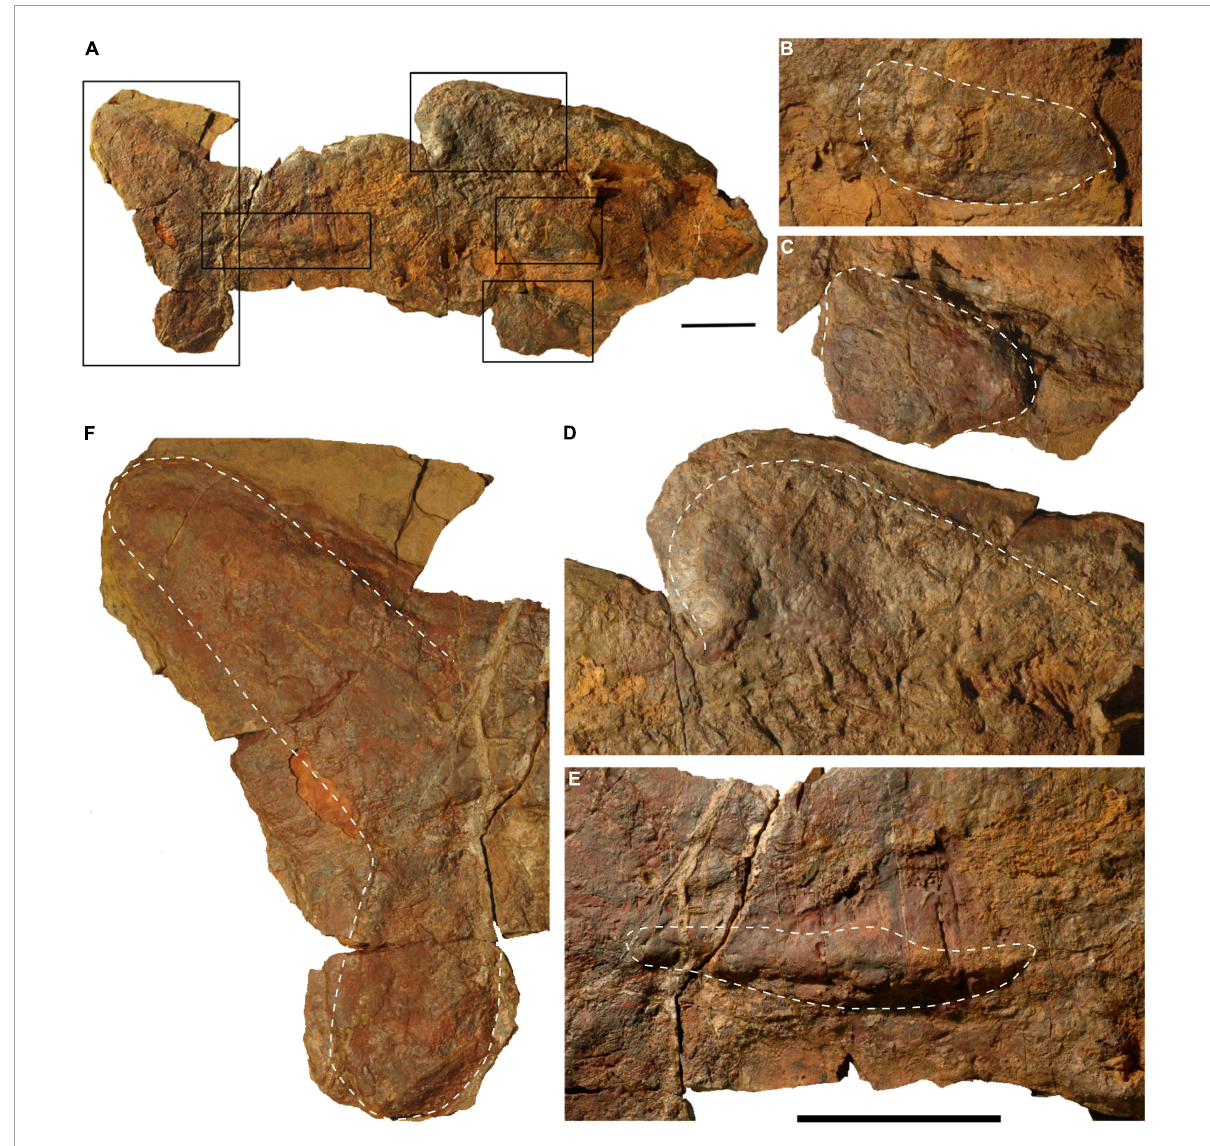
FIGURE7 Fins of Amazichthys trinajsticae gen. et sp. nov., AA.MEM.DS.8, the holotype. (A) , and a close-up in lateral-view of both pectoral fins (B,C) , the dorsal fin (D) , a structure apparent to a lateral keel (E) , and the caudal fin (F) . The scale bar corresponds to 100 mm (same scale for B–E ).